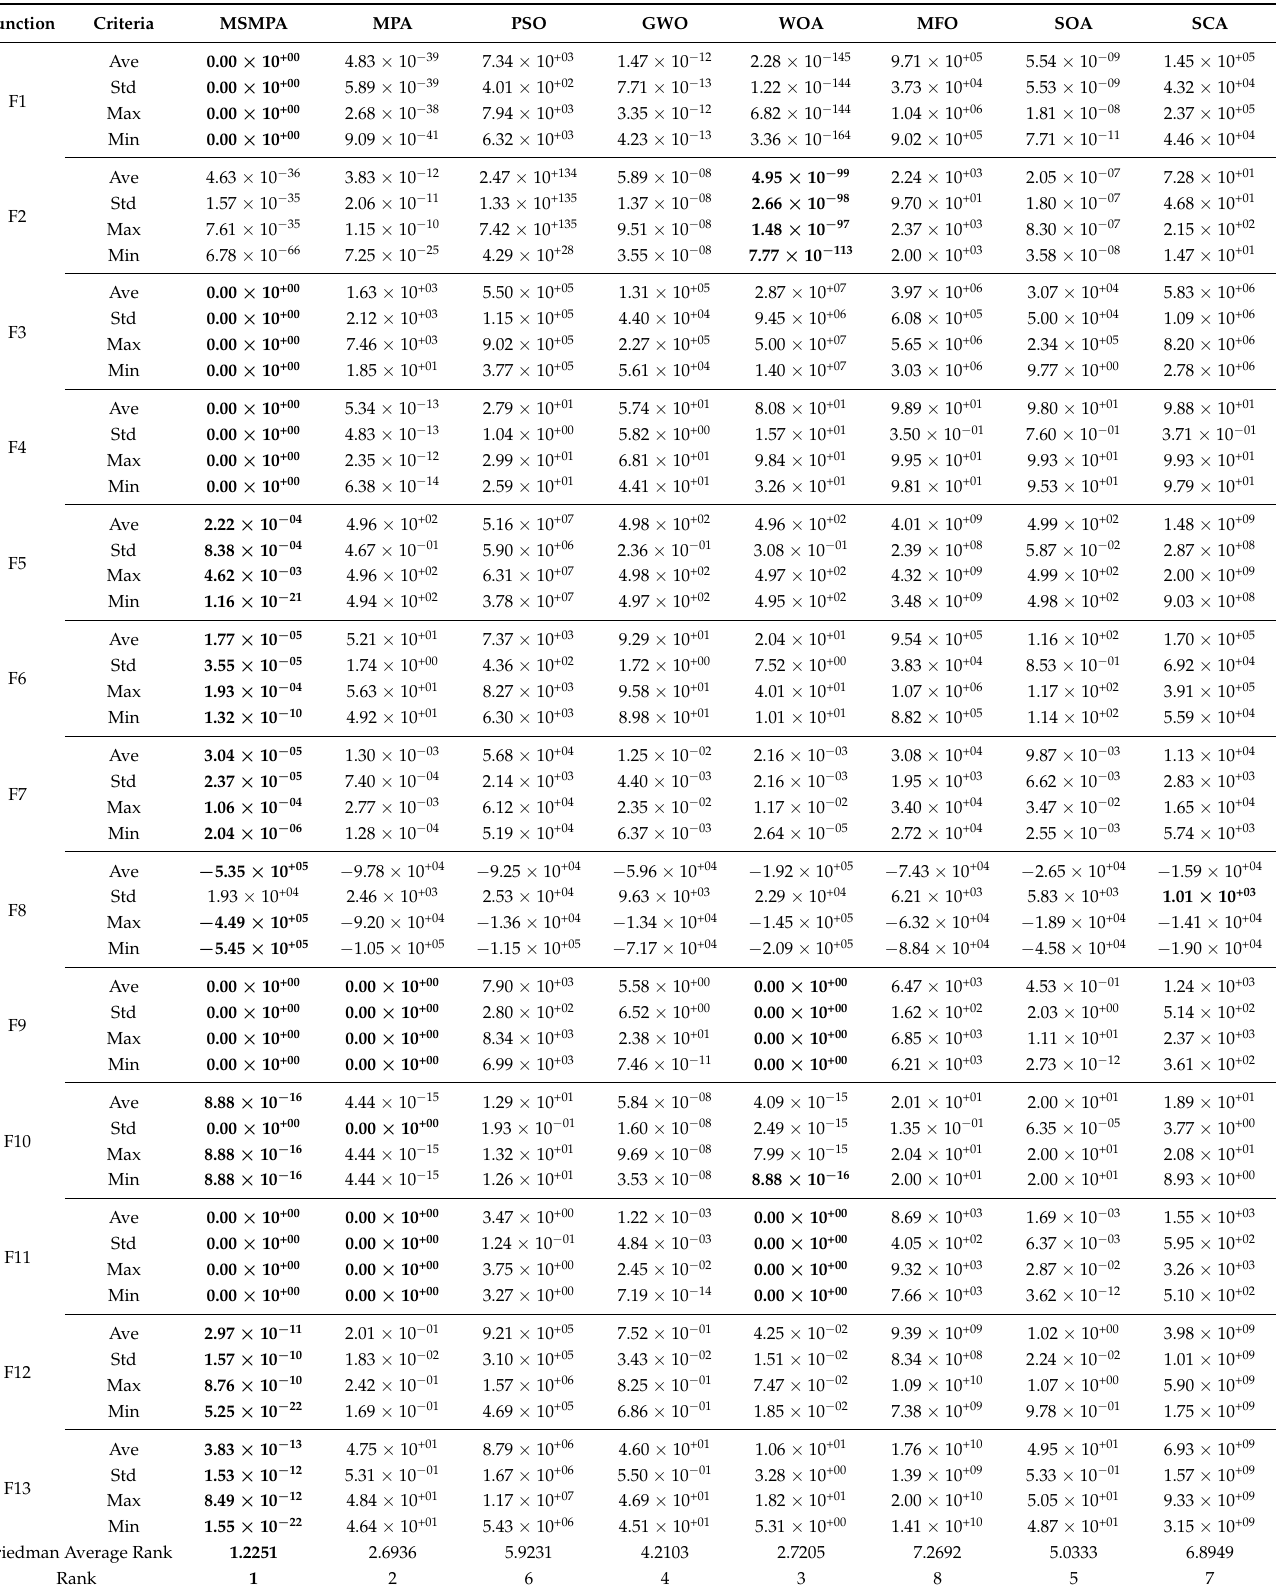
Table A6. Test results for each high-dimensional function with dimension